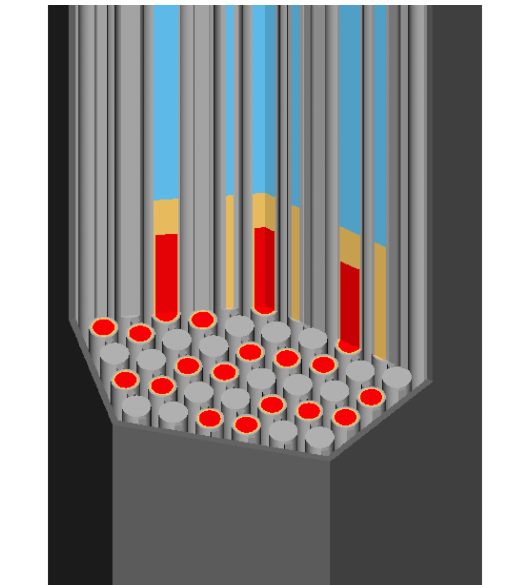
Figure 6. SCALE half-worth driver assembly model of the EBR-II. The fuel (red) is located in every second rod, and the other rods (gray) are solid steel cylinders. Bond sodium in the fuel rods is displayed in yellow, and the gas plenum is shown in